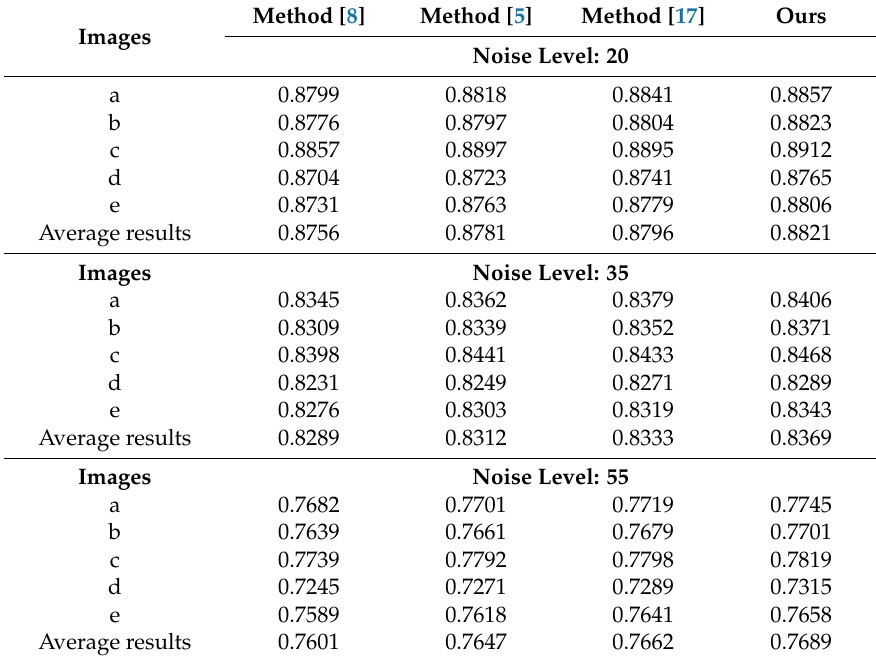
Table 2. Quantitative measurement results using SSIM on UAV testing images with different noise